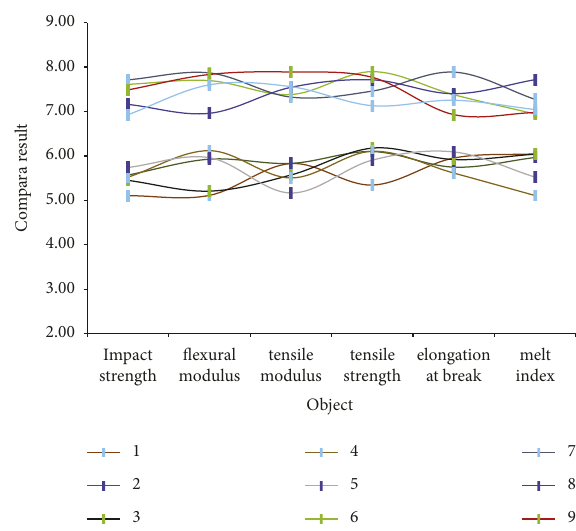
Figure 7: Carbon nanotube performance results before and after UV exposure application.